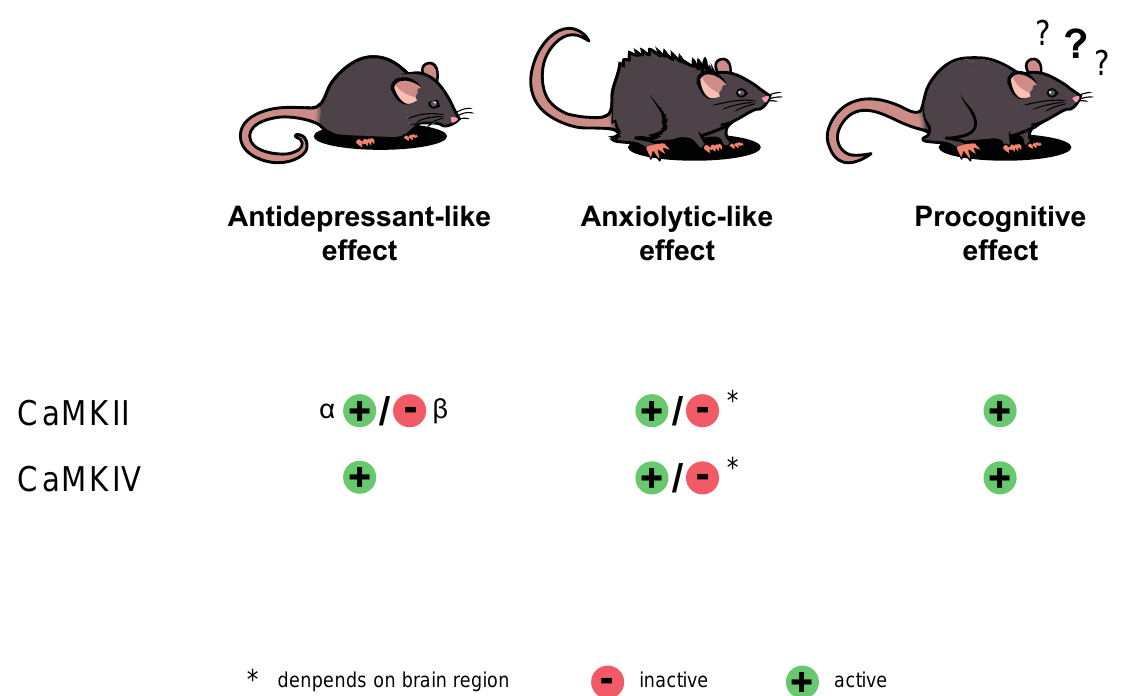
Figure 4. The role of calcium/calmodulin-dependent kinase (CaMK) II and IV in antidepressant-like, anxiolytic-like, and procognitive effects. The procognitive effect requires activation of both CaMKII and CaMKIV. For antidepressant-like activity to be induced, CaMKII α and CaMKIV need to be activated, and CaMKII β inactivated. The data on the anxiolytic-like effect depend on the studied brain region.